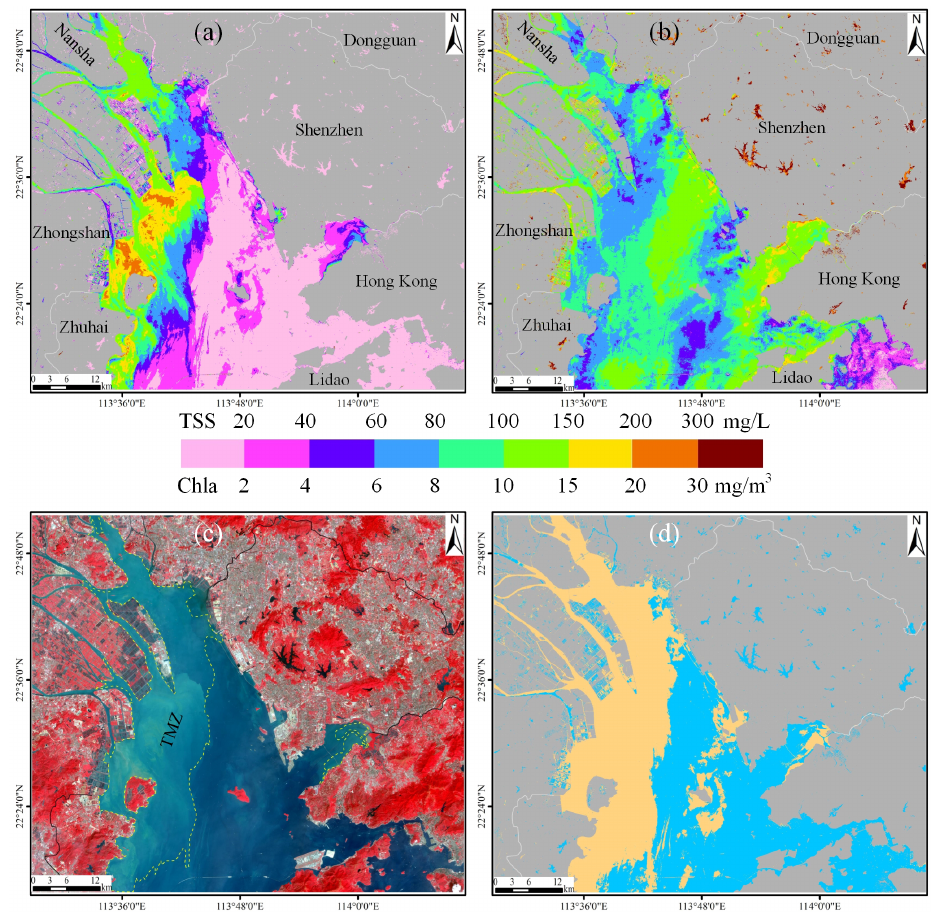
Figure 8. The estimated TSS concentrations (a) , Chl a concentrations (b) , false color imagery (USGS, 1982; NASA, 2001) and the visual- interpretation TMZ results (regions indicated by yellow dashed frames) (Wang et al., 2020b) (c) , and extracted TMZ results, indicated by mango coloring, (d) in the PRE on 18 October 2015 (high-flow